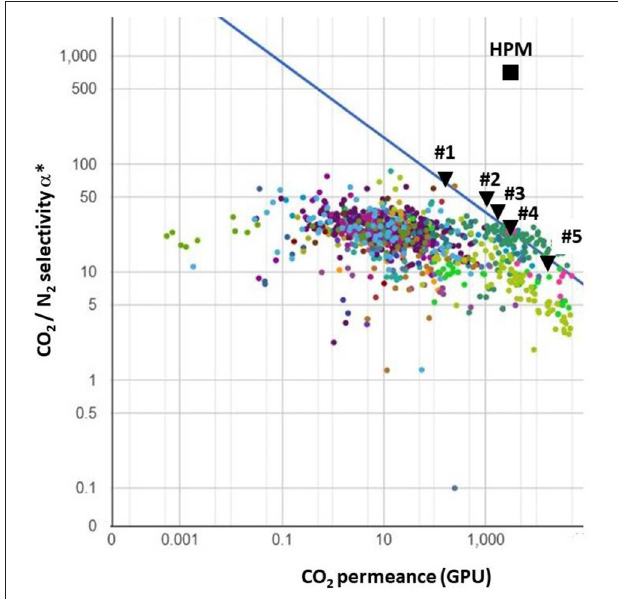
FIGURE 3 | CO 2 /N 2 gas pair trade-off curve [from Robeson (2008), adapted]. Polymeric membrane materials listed in Table 2 are indicated (#1–#5). The filled square [HPM, High-Performance Material ( Li et al., 2013; Yuan et al., 2017 )] corresponds to a recently reported inorganic material used for simulation